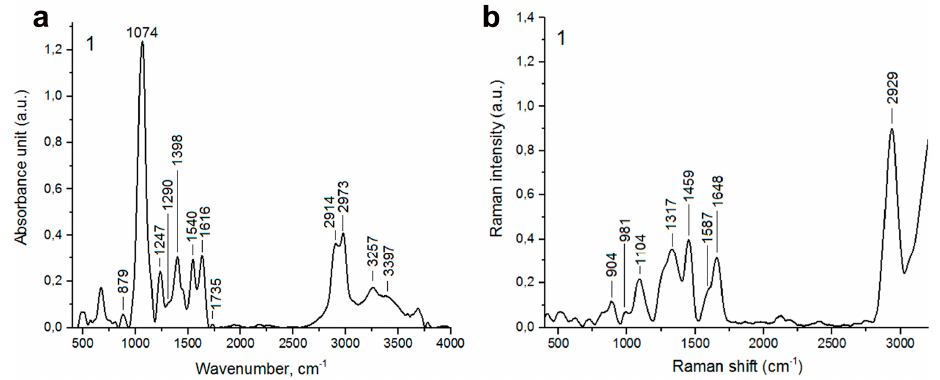
Figure 4. A representative FTIR spectrum ( a ) and Raman spectrum ( b ) of a clinical Candida albicans isolate 1. Characteristic peaks are denoted; a.u., arbitrary units. A comma was used as a decimal separator.